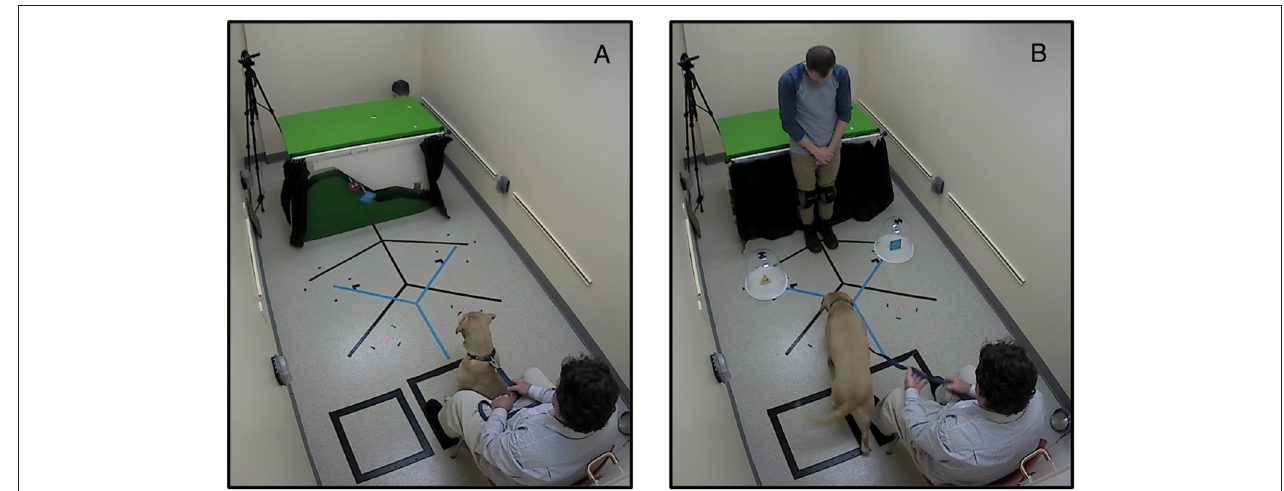
FIGURE 1 | Testing set-up showing a participating dog (A) watching the puppet show and (B) choosing between the helper and hinderer shapes. Written informed consent was obtained from the depicted individuals for the publication of these images.